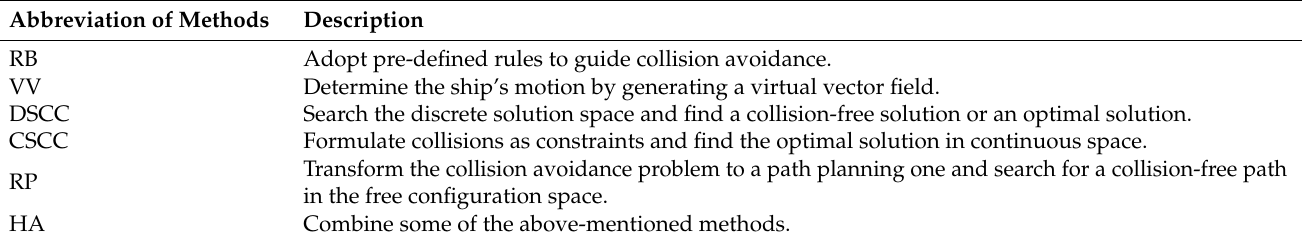
Table 5. Classification of intelligent collision avoidance methods during